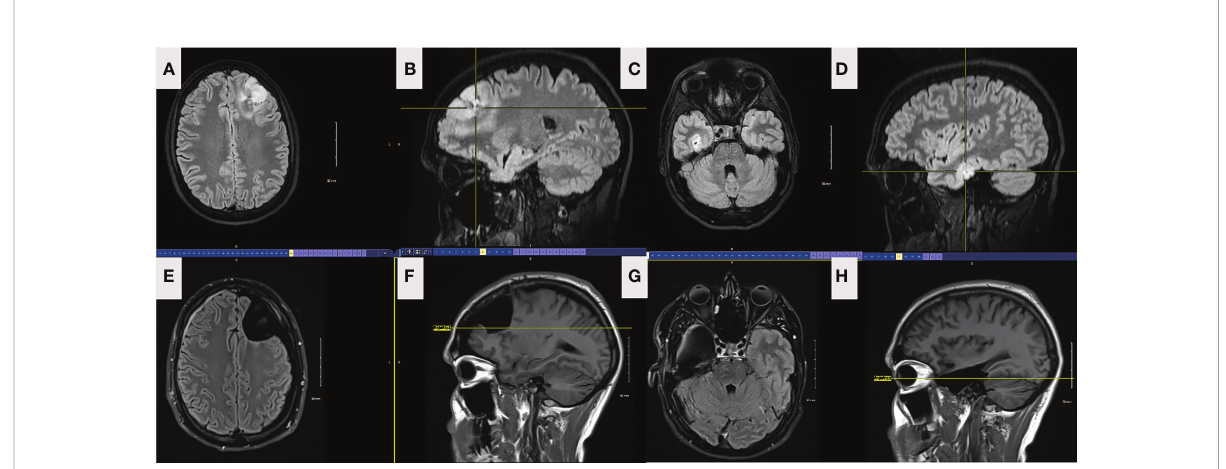
FIGURE 3 FLAIR axial (A) and sagittal (B) preop MRI of the left frontal lesion in patient 2. FLAIR axial (C) and sagittal (D) preop MRI of the right temporal lesion in patient 2. Axial (E) and sagittal (F) FLAIR MRI from left frontal tumor resection in patient 2, 5 months postoperatively. The resection was taken around all margins of the FLAIR lesion until functional borders were found, including into the corpus callosum across the midline. FLAIR MRI axial (G) and sagittal (H) from right temporal tumor resection in patient 2, 4 months postoperatively. The resection was taken beyond the margins of the FLAIR lesion.